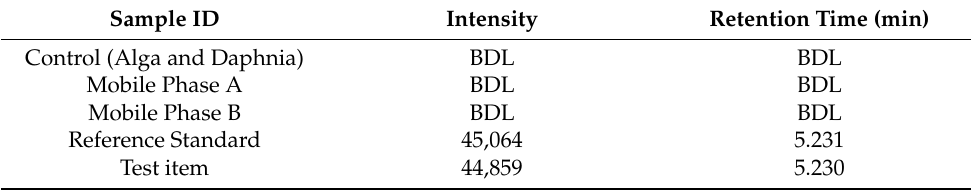
Table 1. Specificity